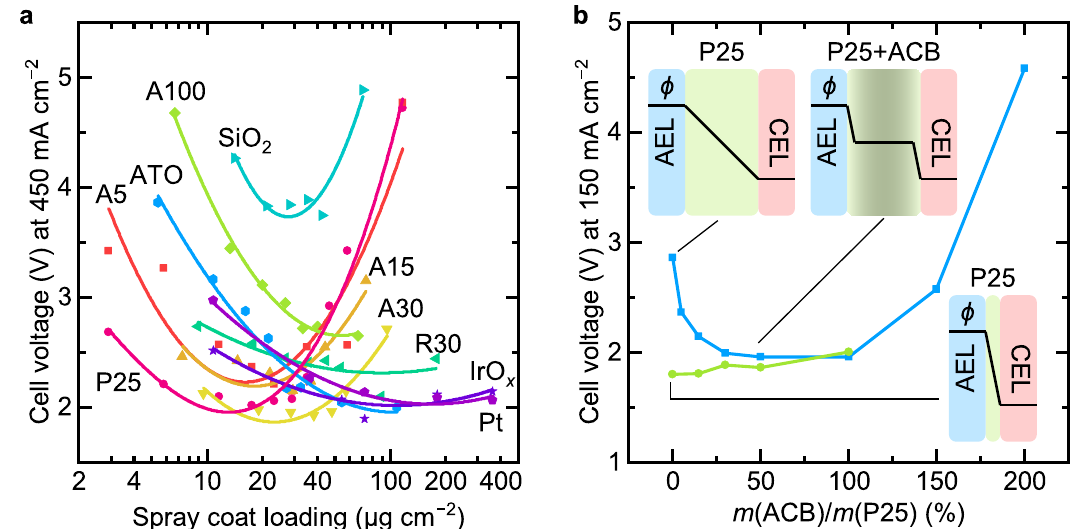
Fig. 6 Performance of BPM electrolyzers with various WD catalysts. a Cell voltage of BPM electrolyzers as a function of spray-coated loading of various WD catalysts at 450 mA cm − 2 . Lines are added to serve as a guide for the eye. For various TiO 2 , A = anatase and R = rutile. The number denotes the size of the nanoparticles (nm) provided by the manufacture. ATO = Sb:SnO 2 . b Cell voltage of BPM electrolyzers as a function of the mass ratio of acetylene carbon black (ACB) and TiO 2 -P25 at 150 mA cm − 2 . The blue line is for a thick layer of ∼ 120 μ g cm − 2 ( ∼ 2.4 μ m) TiO 2 -P25, and the green line is for a thin layer of TiO 2 -P25 at optimal loading ∼ 18 μ g cm − 2 ( ∼ 360 nm). Only one of each type of device was fabricated for the data in this fi gure to illustrate trends, except for TiO 2 -P25. The error was estimated to be less than 5% (one standard deviation) based on seven devices fabricated with the best loading of TiO 2 - P25 catalysts (Supplementary Fig. S3). Insets are schematic proposed electric-potential pro fi les across the BPM